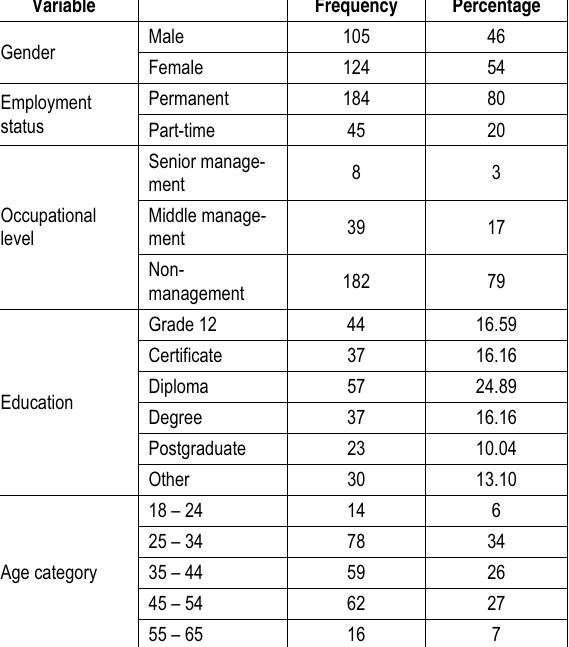
Table 1. Demographical characteristics